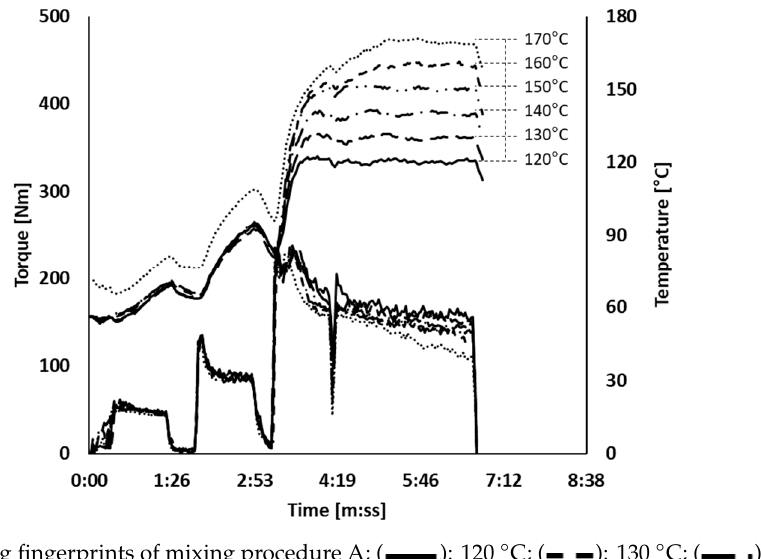
Figure 1. Mixing fingerprints of mixing procedure A; (